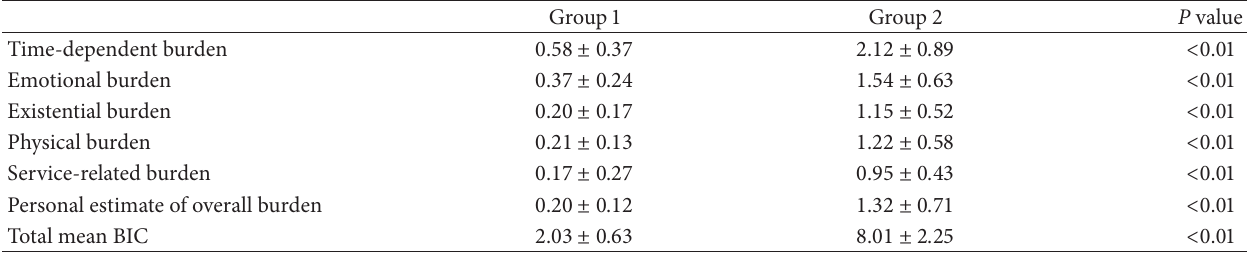
Table 2: The modified Burden Index of Caregivers scores among caregivers of patients with varying degrees of visual impairment.